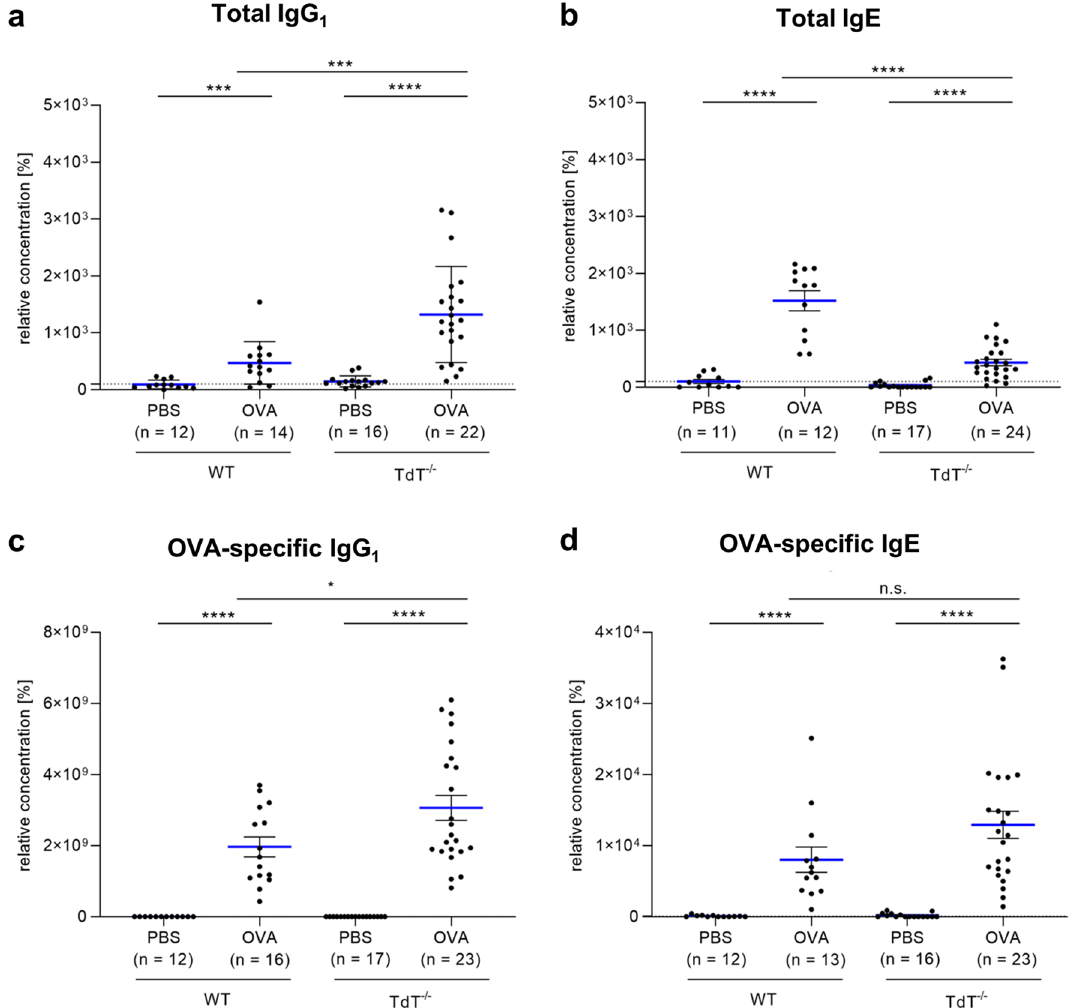
Figure 1. Serum immunoglobulin levels. In serum of wt and TdT −/− mice, both sensitized and non-sensitized, immunoglobulin levels of ( a ) total IgG 1 , ( b ) total IgE, ( c ) OVA-specific IgG 1 and ( d ) OVA-specific IgE were measured using ELISA. Sensitization induced a significant rise in OVA-specific IgG 1 and IgE levels. No significant differences between wt and TdT −/− mice were observed in OVA-specific IgE levels. Total IgE and total IgG 1 levels were significantly increased after sensitization for both strains. The increase in IgG 1 levels was significantly higher and the increase in IgE levels was significantly lower in TdT −/− mice when compared to wt (mean shown as blue lines, SEM shown as black